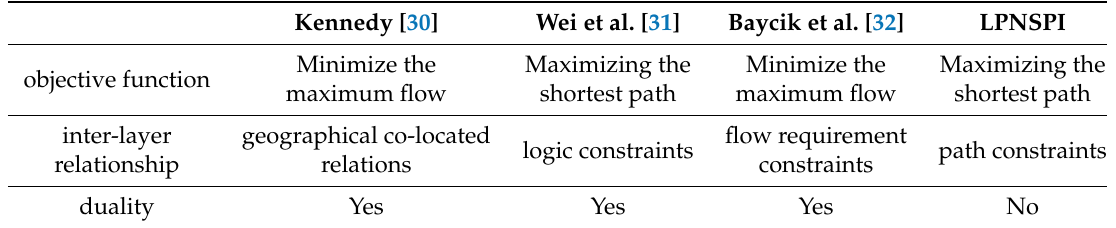
Table 1. Comparisons with LPNSPI and other layered network interdiction